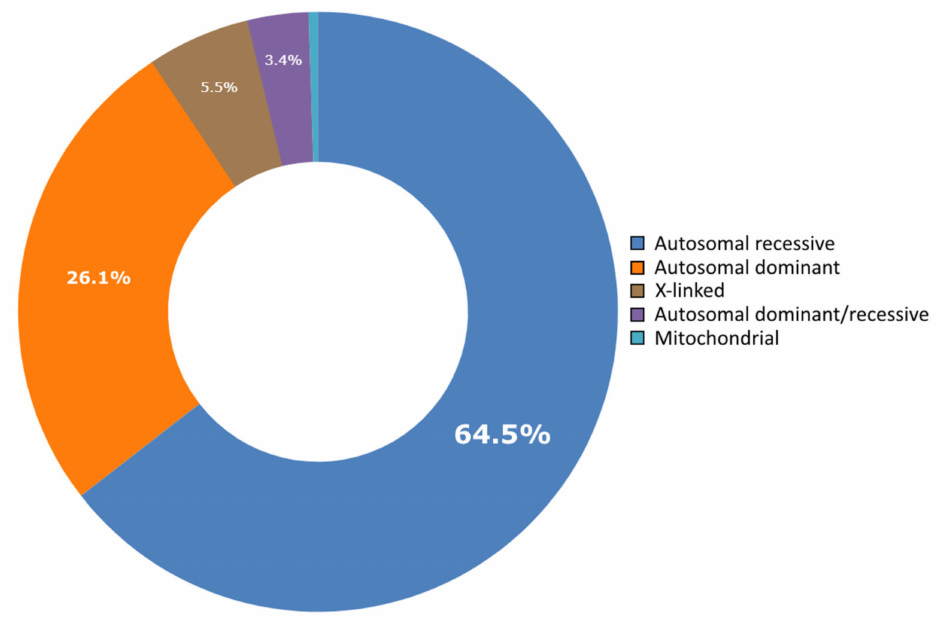
Figure 2. Distribution of mode of inheritance of diseases reported in Lebanese subjects in